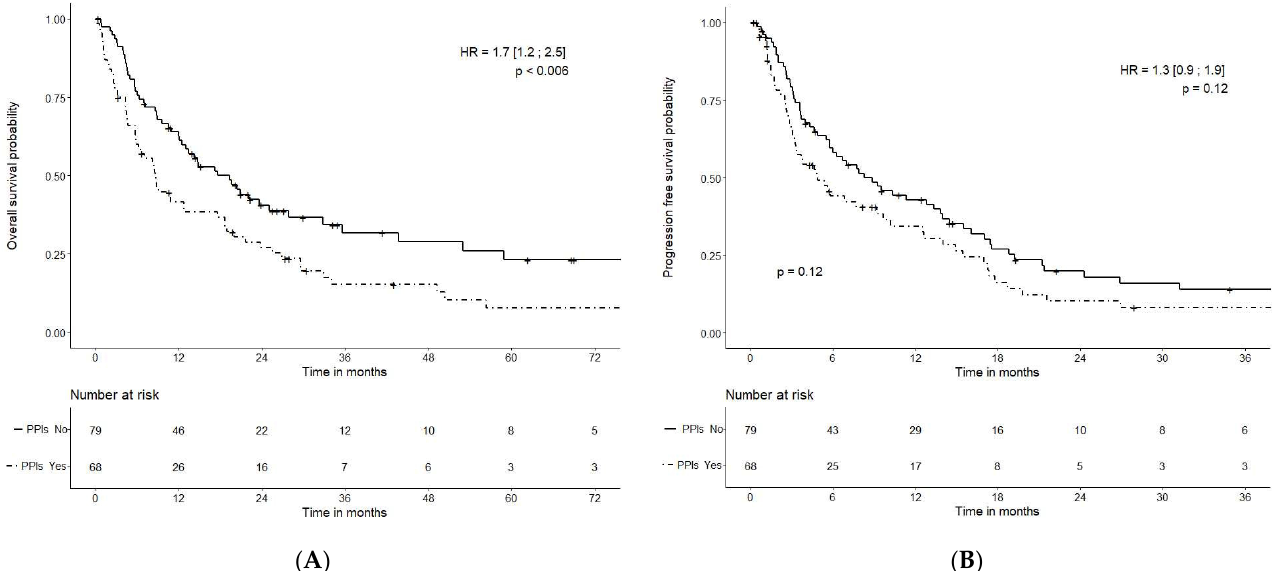
Figure 1. Overall survival ( A ) and progression-free survival ( B ), depending on PPI administration. The mPFS was 8.3 (95% CI: 5.7–14.0) months in cohort 1 (no PPIs) and 4.9 (95% CI: 3.3–10.2) months in cohort 2 (PPIs) [HR = 1.3 (95%CI: 0.9–1.9); p = 0.12] (Figure